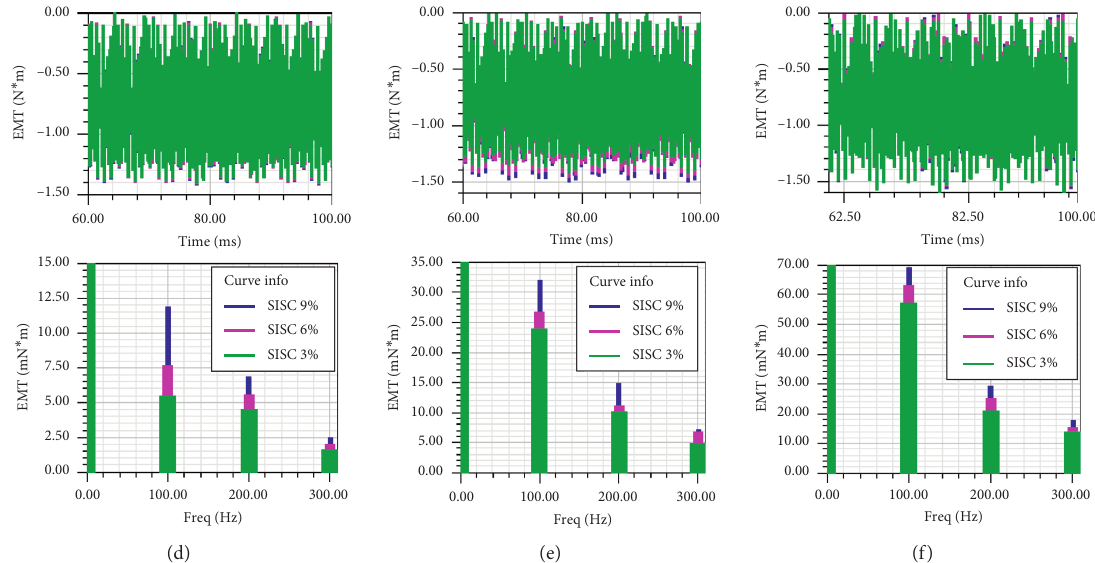
Figure 12: EMTcurves and spectra in CF cases by FEA: (a) SISC 3% and different SAGE degrees, (b) SISC 6% and different SAGE degrees, (c) SISC 3% and different SAGE degrees, (d) SAGE 10% and different SISC degrees, (e) SAGE 20% and different SISC degrees, and (f) SAGE 30% and different SISC